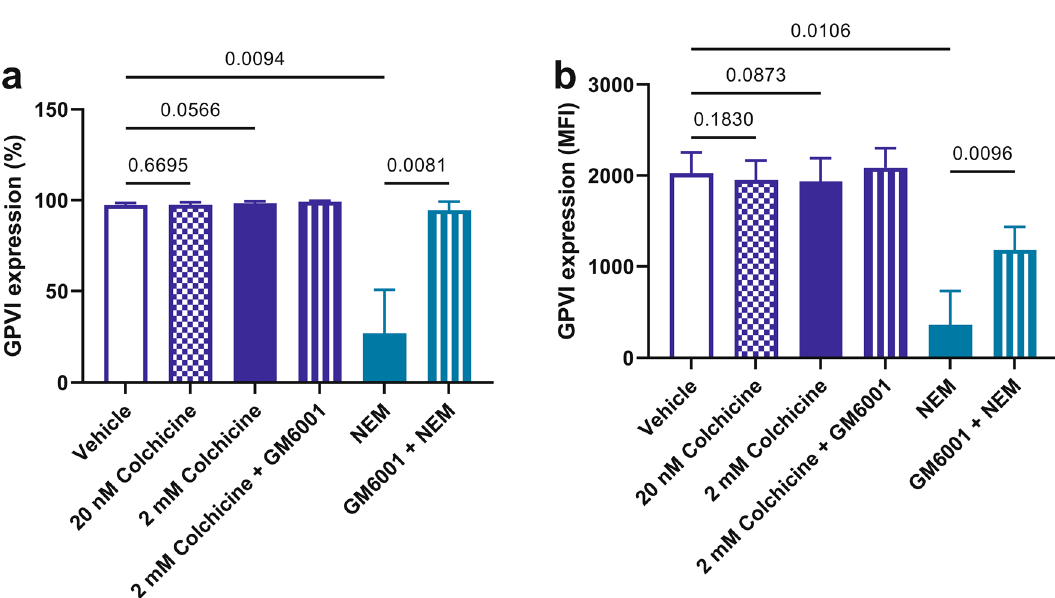
Figure 4. Colchicine does not cause GPVI shedding. Colchicine does not change platelet GPVI expression in PRP as assessed by %GPVI expression ( a ) or GPVI mean fluorescence intensity ( b ). GPVI was shed in response to the positive control (NEM, p = 0.009 for % and p = 0.01 for MFI) and rescued with GM6001 (a broad-spectrum metalloproteinase inhibitor, p = 0.008 for % and p = 0.01 for MFI). Statistical significance was determined by Students paired t test; data presented as mean ± SD; n =